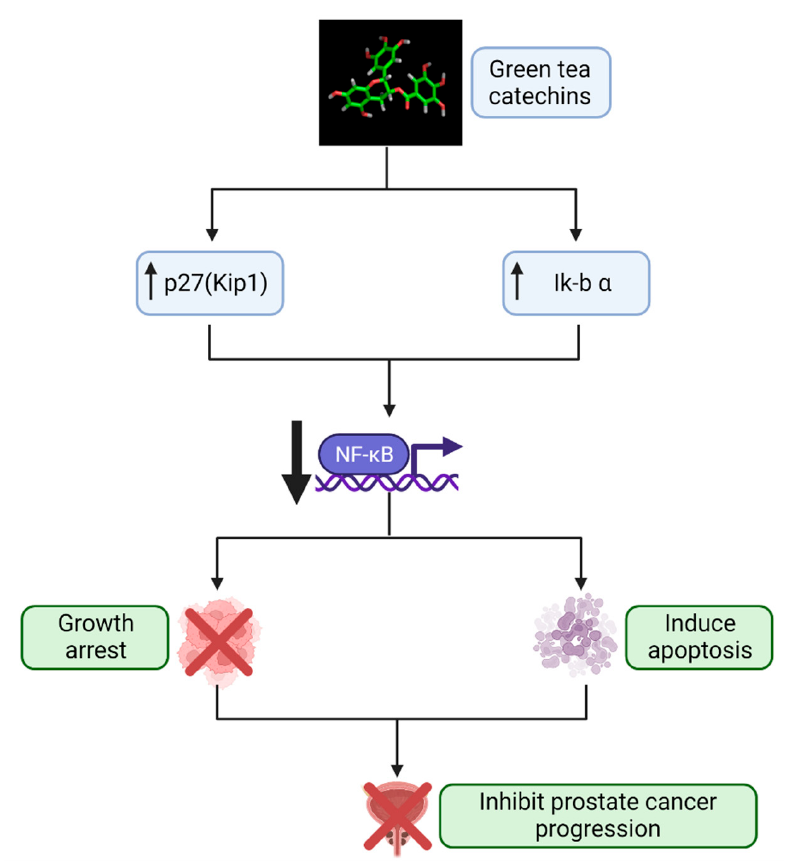
Figure 1. Mechanistic pathway by which GTCs prevent PCa progression. In vitro studies [41–44] demonstrate that GTCs block proteasomal activity in PCa cells, leading to build-up of proteasomal substrates Kip1 and Ik-b α that subsequently downregulate the activity of NF- κ B. This inhibits the cell cycle and elicits apoptosis in these PCa cells. GTCs, green tea catechins; Ik-b α , NF- κ B inhibitor alpha; NF- κ B, nuclear factor kappa B; PCa, prostate cancer. Created with Biorender.com (accessed on 1 July